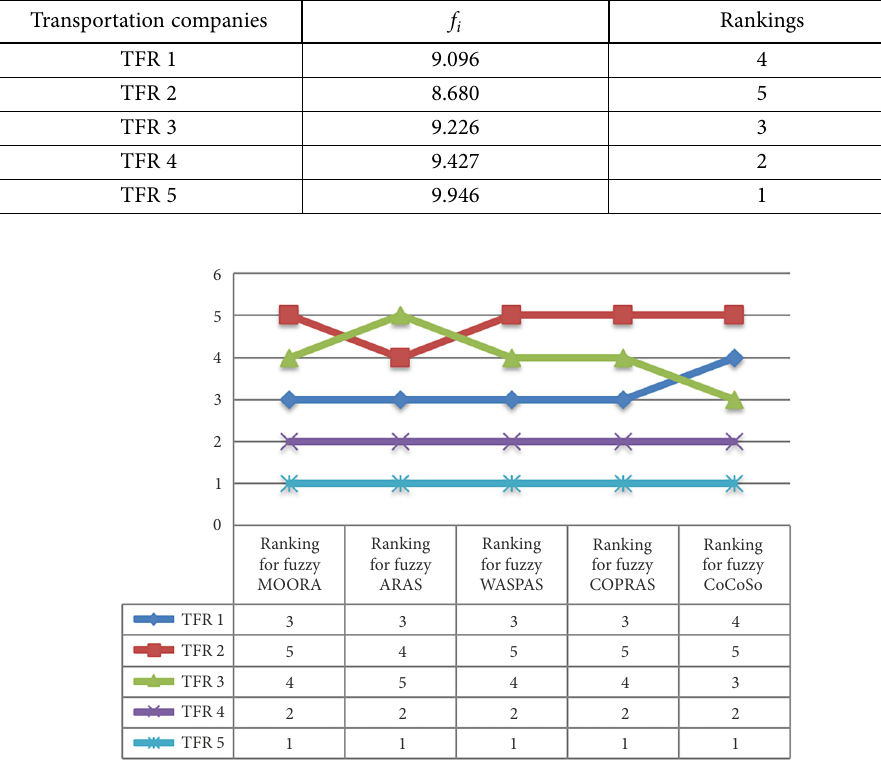
Figure 1. The results of the sensitivity